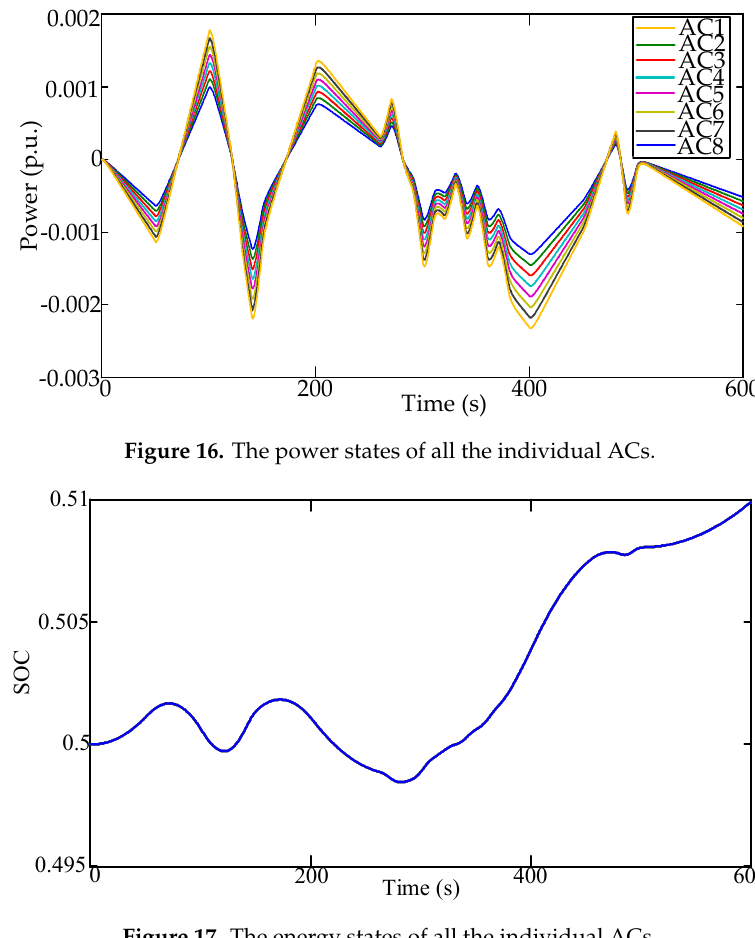
Figure 17. The energy states of all the individual ACs.